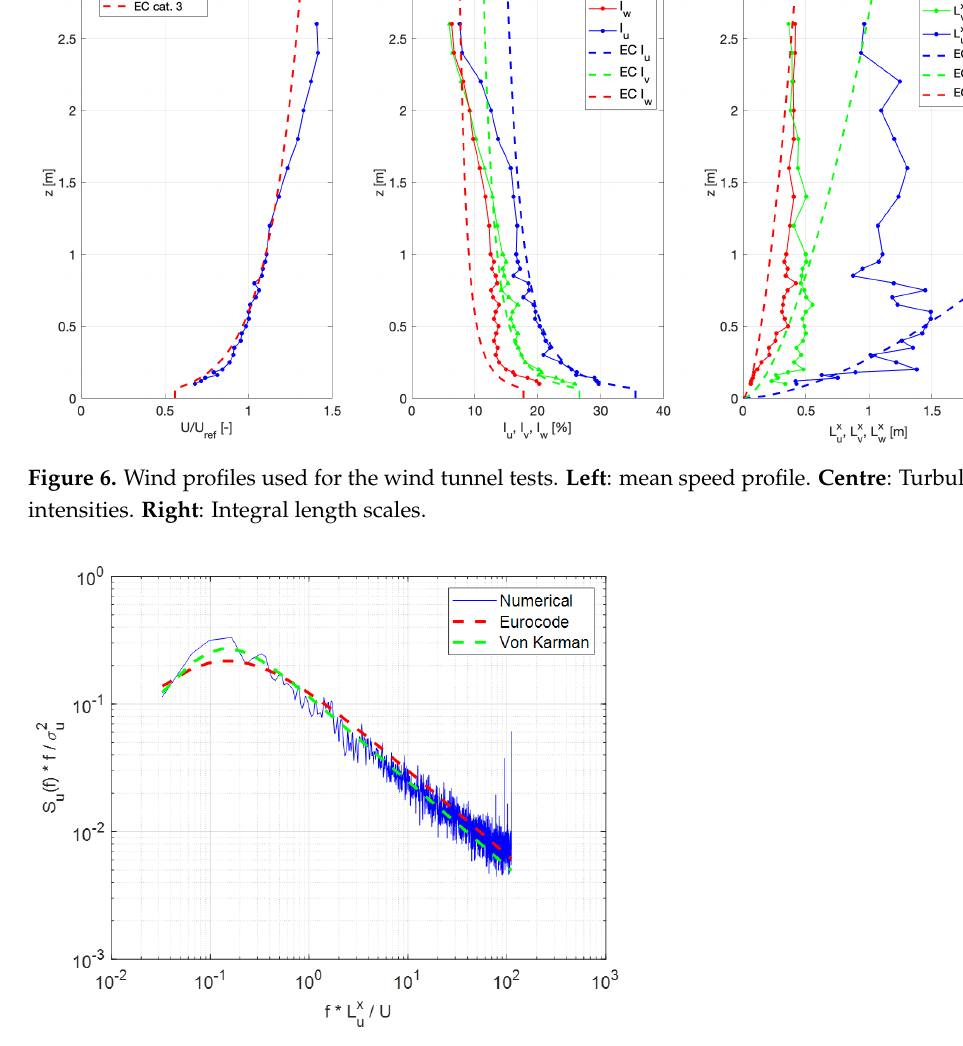
Figure 7. Streamwise velocity spectrum at 1 m height compared to the Von-Karman spectrum and to the Eurocode